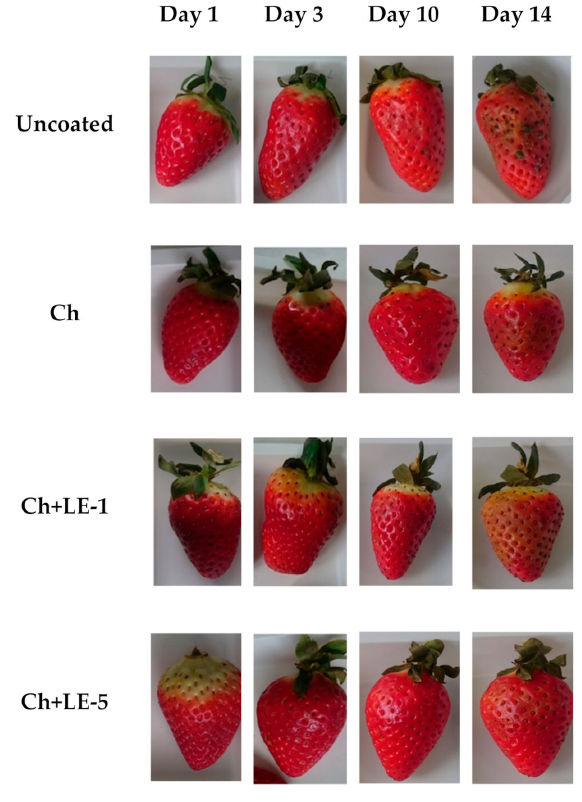
Figure 5. Visual appearance of uncoated, chitosan- and chitosan-licorice-coated strawberries corresponding to 1, 3, 10 and 14 days of storage at 4 ◦ C.